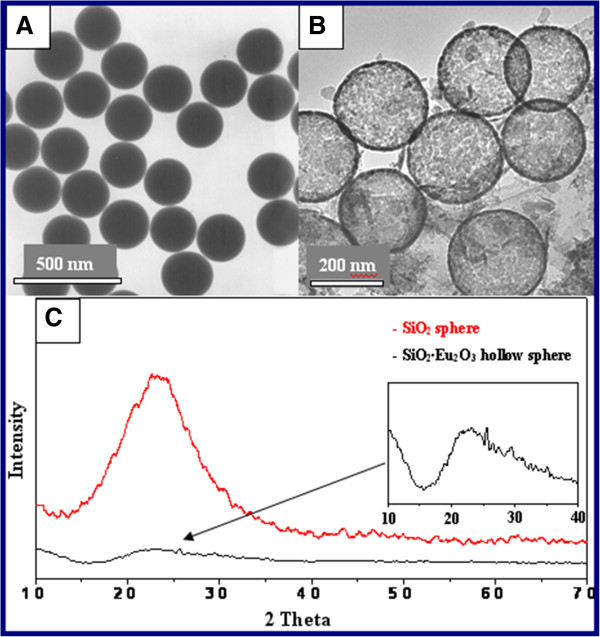
TEM image of SiO2 sphere (A), HRTEM image of SiO2∙Eu2O3 HSs (B), XRD patterns of SiO2 sphere and SiO2∙Eu2O3 HSs (C). The insert is magnification of one segment of XRD.